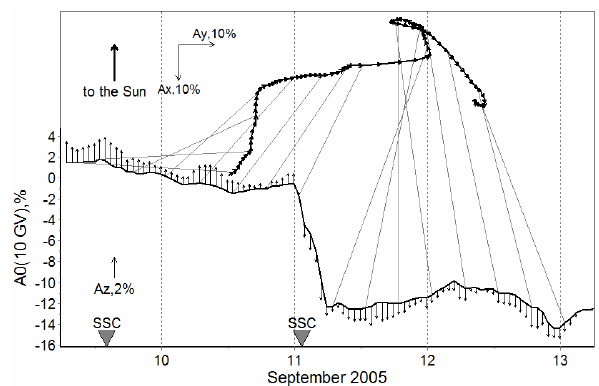
Figure 3: Forbush effect on September 15, 2005: Behavior of the CR density and vector of equatorial component of CR anisotropy in the period from September 15-18, 2005. The dates are presented in the format dd.hh (days.hours). Designations are the same as in Fig.2.